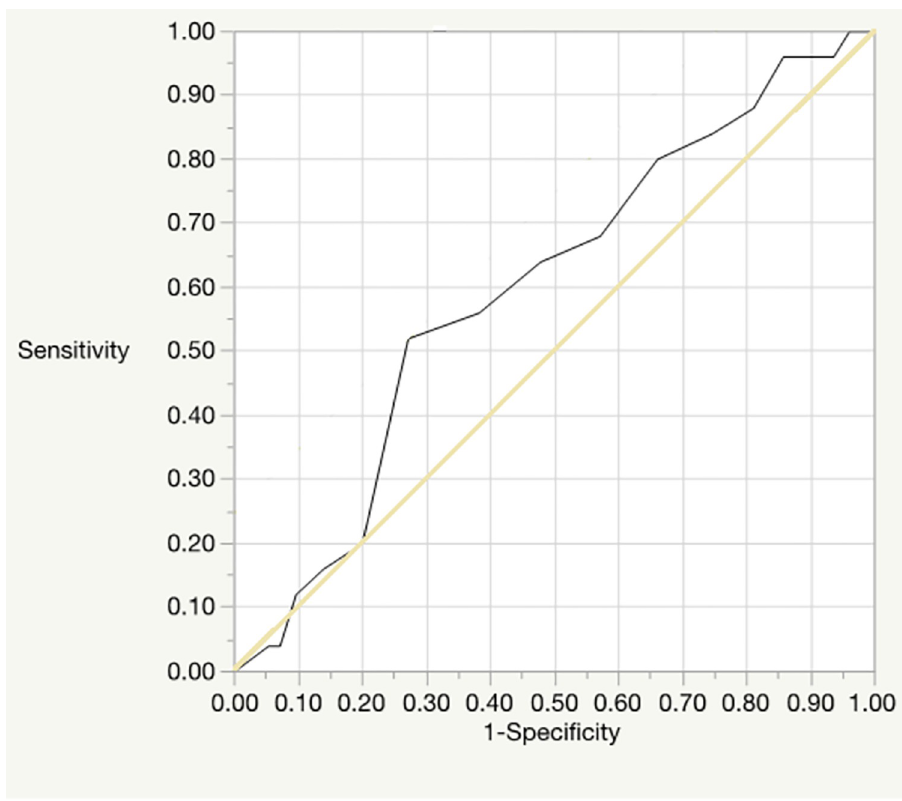
Fig 2. The ROC curve for drug